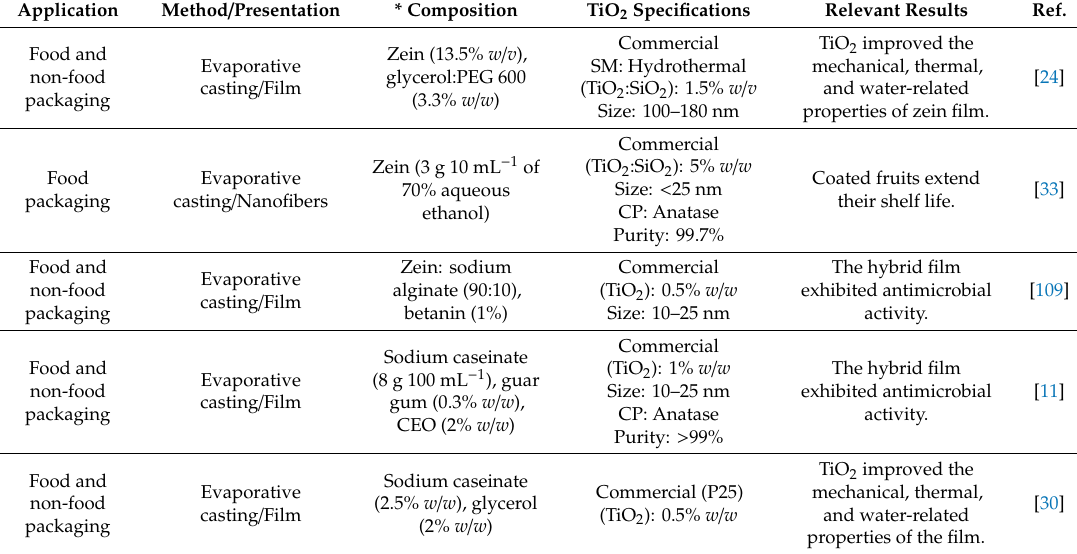
Table 8. E ff ect of TiO 2 incorporation on non-conventional protein-based